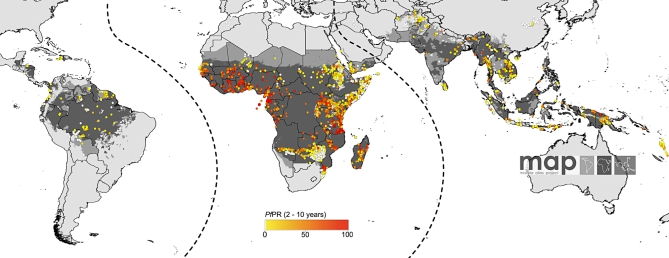
The Spatial Limits of P. falciparum Malaria Risk Defined by PfAPI with Further Medical Intelligence, Temperature, and Aridity MasksAreas were defined as stable (dark grey areas, where PfAPI ≥ 0.1 per 1,000 pa), unstable (medium grey areas, where PfAPI < 0.1 per 1,000 pa), or no risk (light grey, where PfAPI = 0 per 1,000 pa) [17–19]. The community surveys of P. falciparum prevalence conducted between January 1, 1985 and July 31, 2008 are plotted. Of the 8,938 surveys collected, 7,953 satisfied our inclusion criteria for modelling (see Methods and Protocol S1.2) and are shown here. The survey data shown are age-standardized [51] (PfPR2−10) and shown as a continuum of yellow to red from 0%–100% (see map legend). The dashed lines separate the America; Africa+; and the CSE Asia regions.